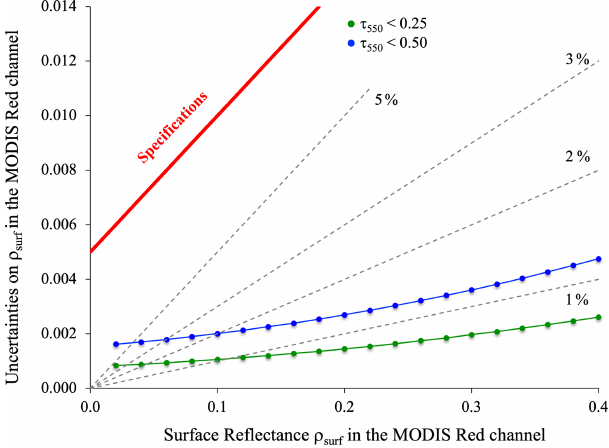
Figure 16. Uncertainties in ρ surf versus ρ surf in the MODIS red channel. Green and blue lines correspond to the uncertainties for two ranges of aerosol optical thicknesses at 550nm ( < 0.25 and 0.5). Relative uncertainties in ρ surf (1%, 2%, 3%, and 5%) are highlighted in dotted lines. The red line indicates the MODIS spec- ifications for surface reflectance